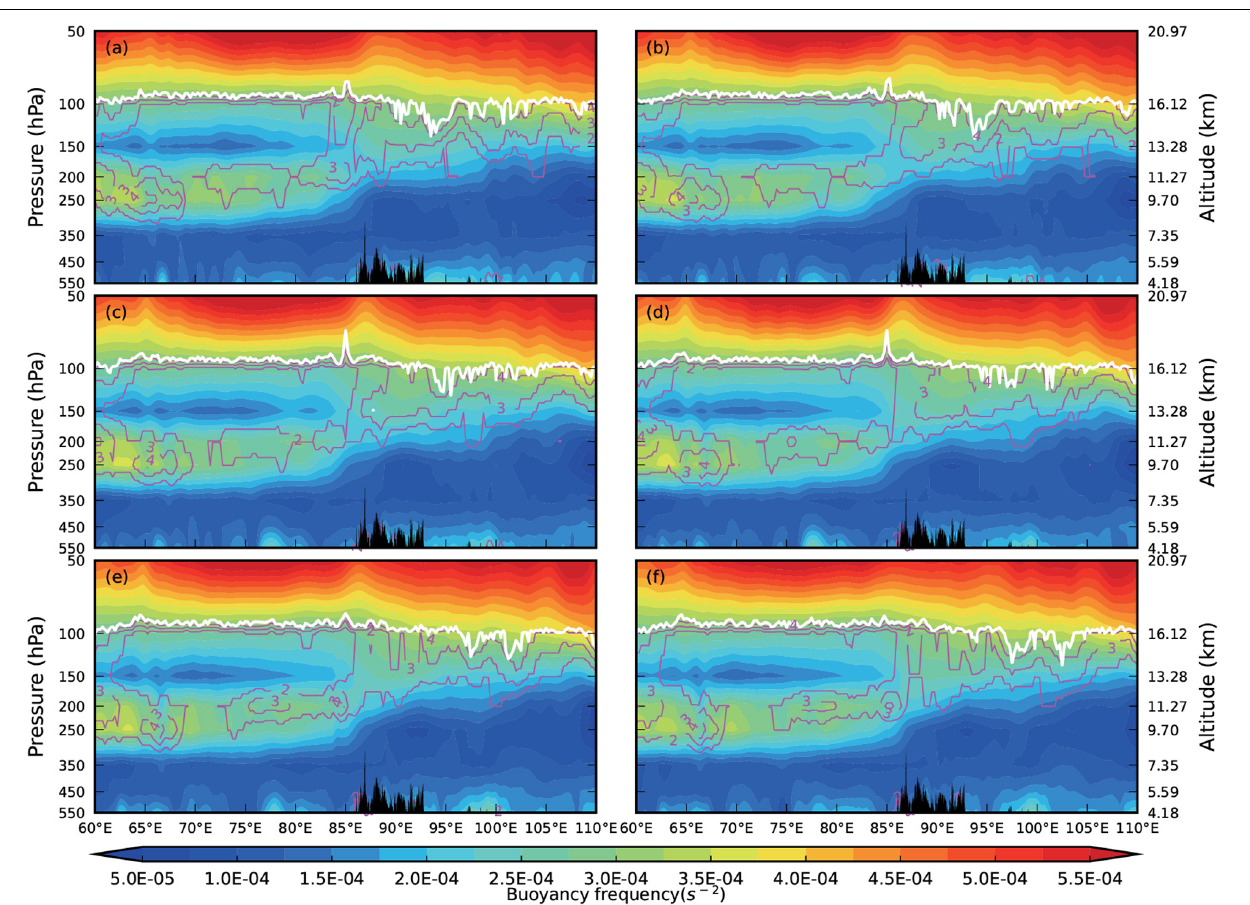
FIGURE 5 | Longitude–height cross section of buoyancy frequency (unit: s − 2 ) along 28 ◦ N from ERA5 reanalysis data on 3 May, 2014. The solid white lines indicate the thermal tropopause and the solid purple lines indicate potential vorticity (unit: PVU). Times shown are (a) 18:00; (b) 19:00; (c) 20:00; (d) 21:00; (e) 22:00; and (f)